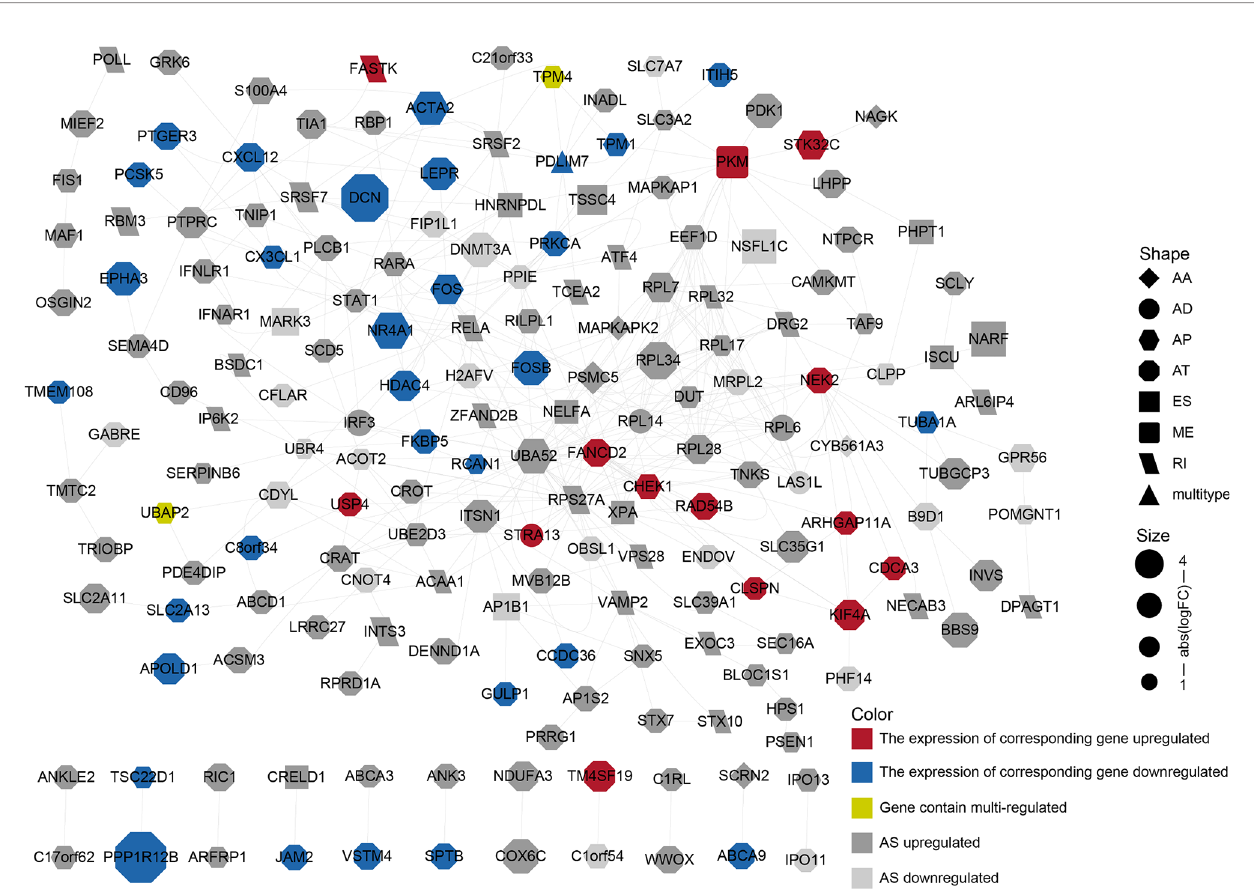
FIGURE 4 | PPI network constructed by different alternative splicing-related genes in BLCA. The dots represent alternatively spliced genes, whereas the edges represent the relationships between the proteins corresponding to those genes. The shapes of the dots represent the AS types; the color of the dots represents the changes in gene expression. The size of the node represents |log2 (fold